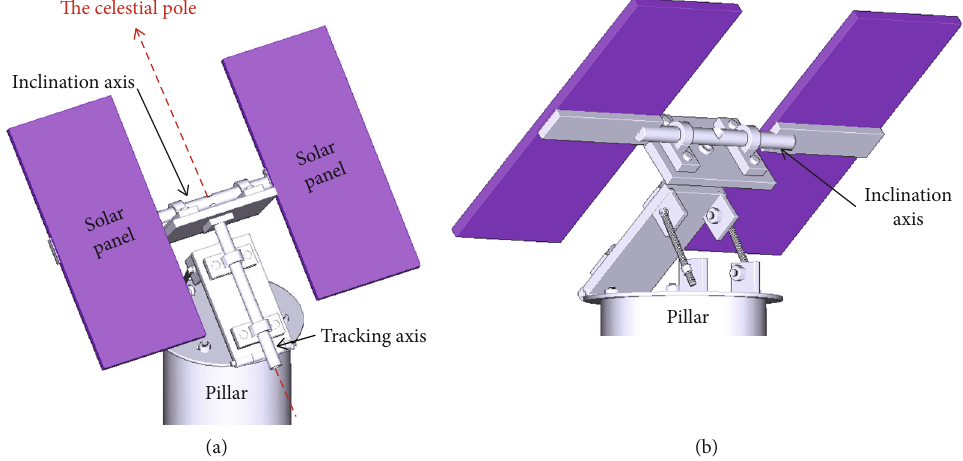
Figure 16: The model of our solar tracker. (a) The solar tracker forward. (b) The solar tracker behind.